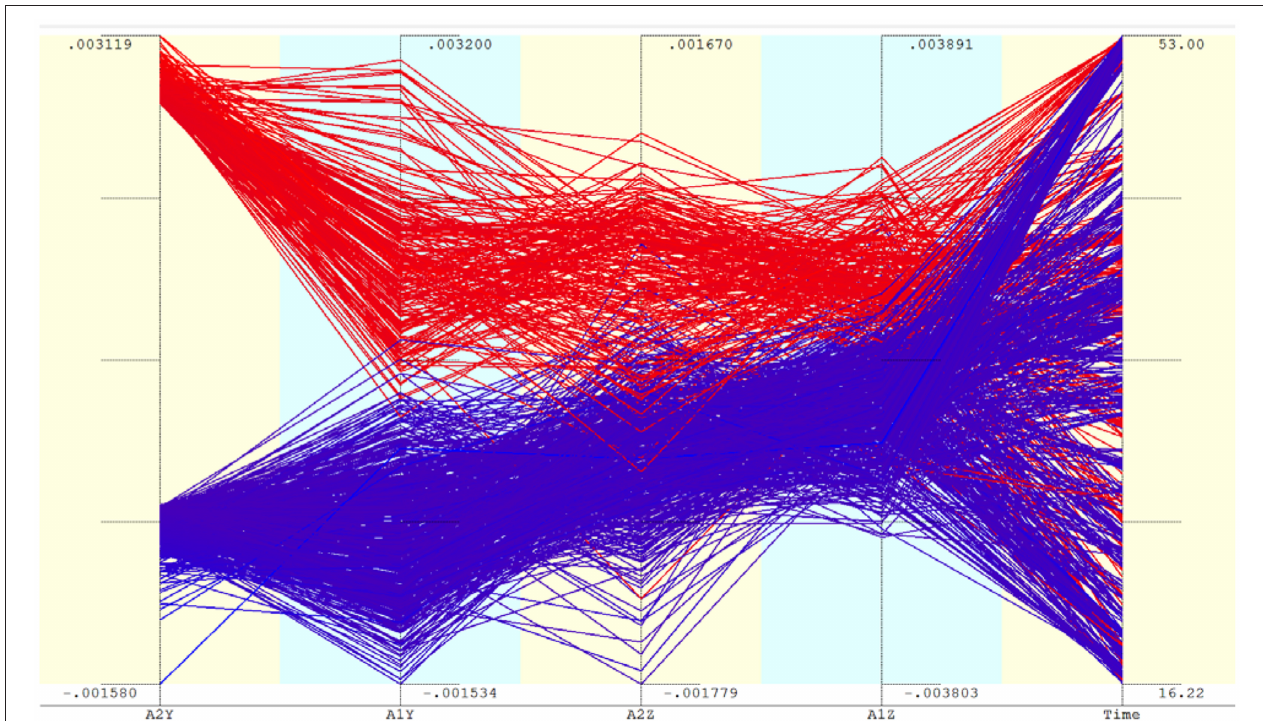
FIGURE 8 | Selected accelerometer readings during the free-vibration phase. Only points with large absolute values of A2Y are chosen for display. During the selected time period, the train is at a distance of 735–98m from the edge of the girder.